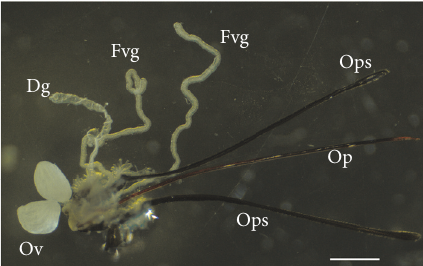
Figure 2: General morphology of Therophilus javanus female reproductive system, showing the two ovaries (Ov), the venom gland composed by two filaments (Fvg), Dufour’s gland (Dg), the ovipositor (Op), and the two ovipositor sheaths (Ops). Bar 1